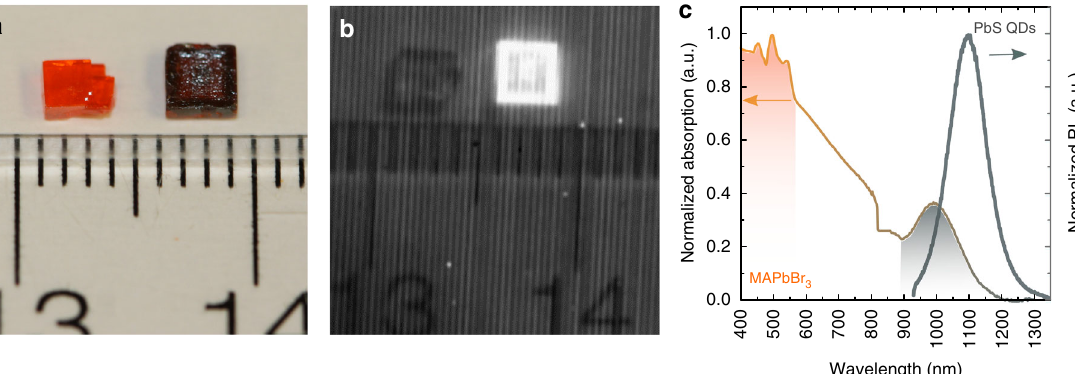
Fig. 2 Material platform of quantum dots inside single crystal (QDISCs). a Pure MAPbBr 3 perovskite crystal (left) and QDISCs (right). QDISC exhibit the color of PbS quantum dots. b Emission from quantum dots under room light captured by a near-infrared camera. c Absorption and